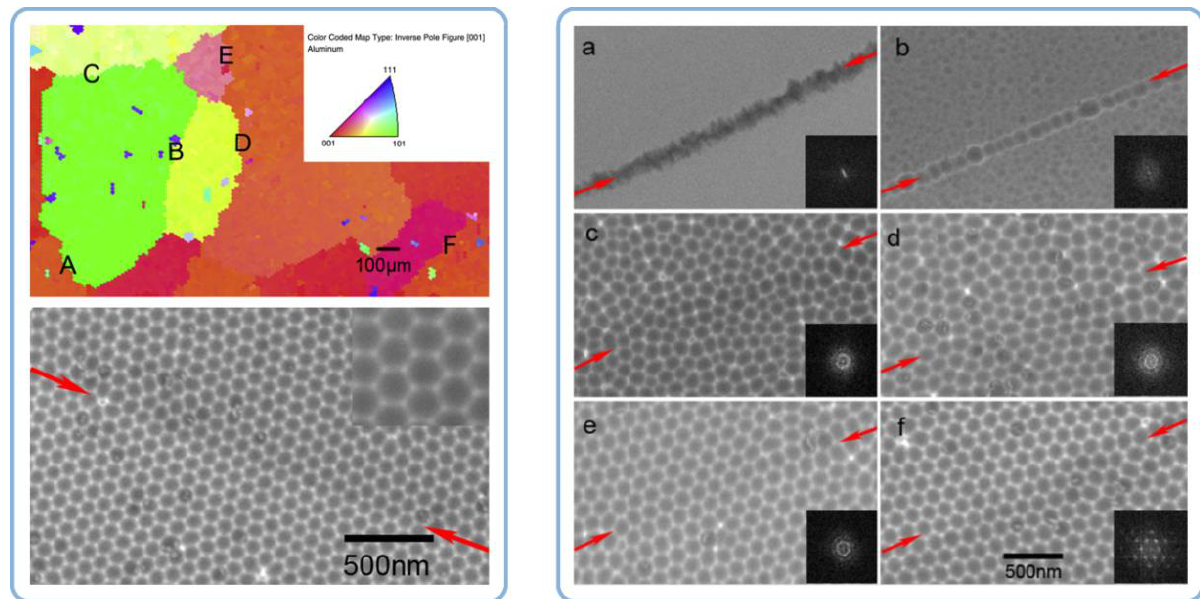
Figure 12. Top left : an orientation map of an Al substrate (obtained using the Electron Backscatter Diffraction method, EBSD) on which different crystallographic directions aligned with the axis normal to the sample surface are coded with different colors (see the inset). Below left : an SEM micrograph of hexagonally ordered concaves on Al surface visible after the removal of PAA by wet etching (the boundary between two Al grains with different orientation is shown with red arrows). Right : the evolution of the Al substrate surface texture above a boundary between two Al grains (marked with red arrows) upon anodizing for 0 min ( a ), 1 min ( b ), 5 min ( c ), 25 min ( d ), 125 min ( e ), and 40 h ( f ). Reproduced with permission from [106]. Copyright 2008 Elsevier.